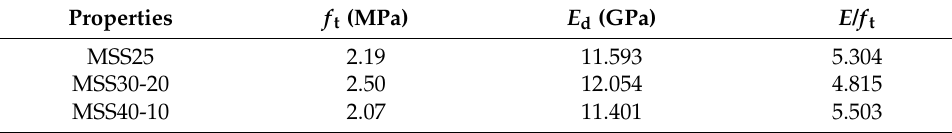
Table 5. Susceptibility of mortars to